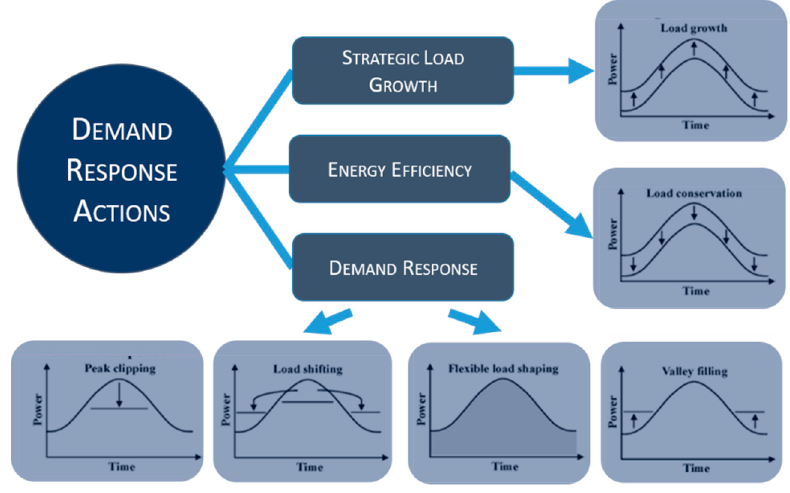
Figure 14. Types of demand response actions [58].